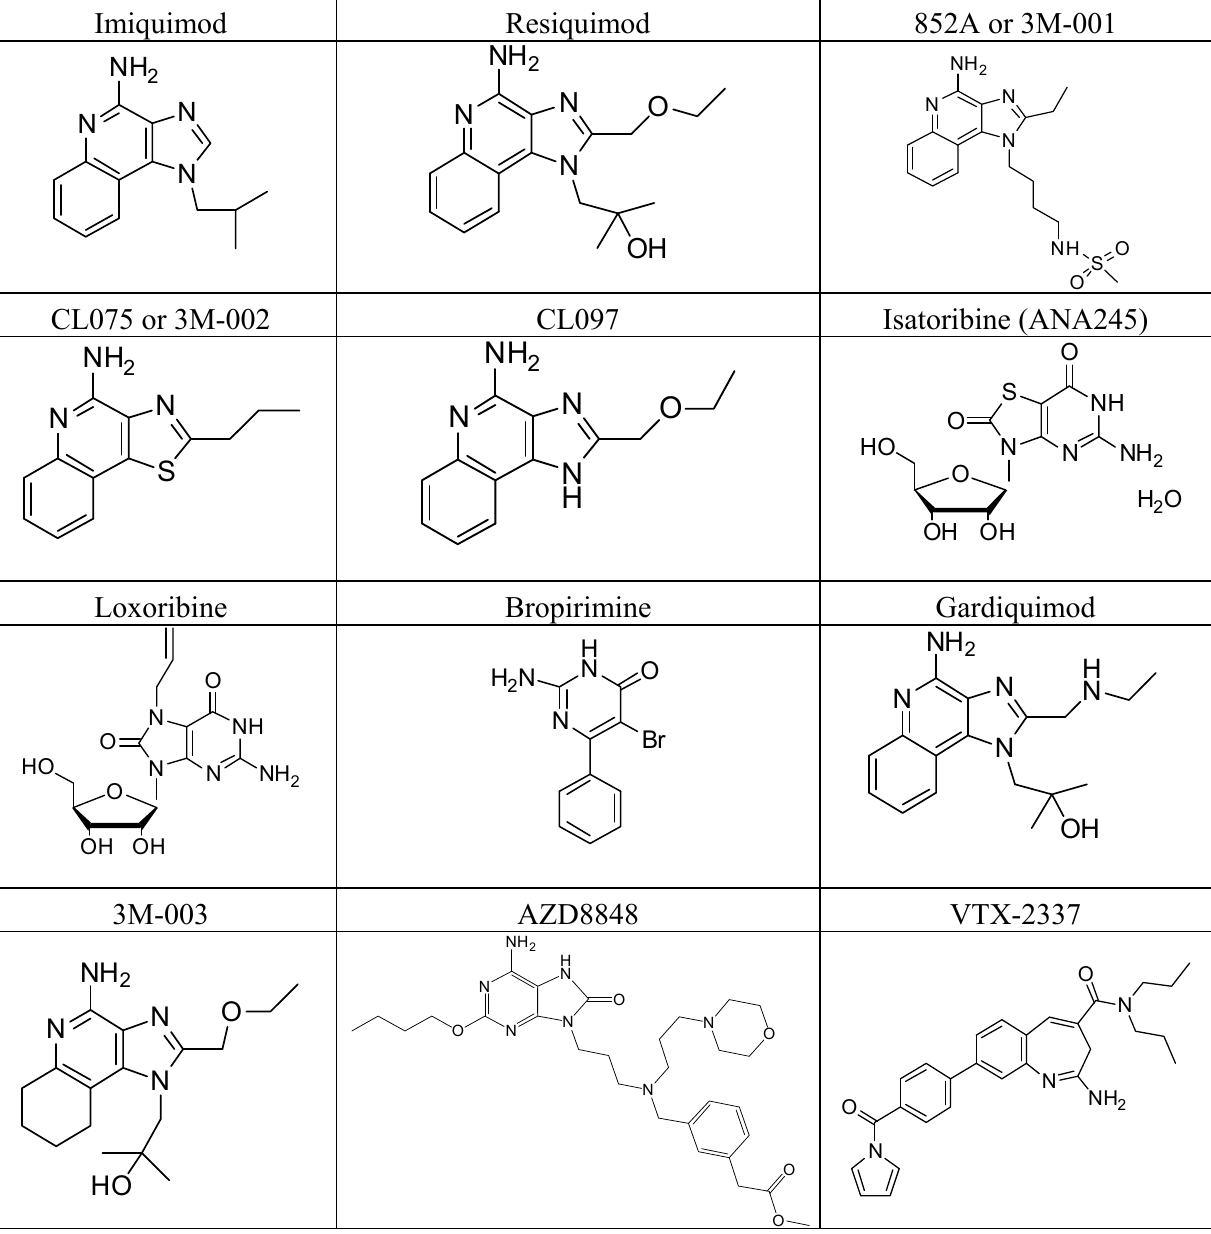
Table 2. Clinical status of TLR7/8-recognizing small molecule nucleoside analogues.